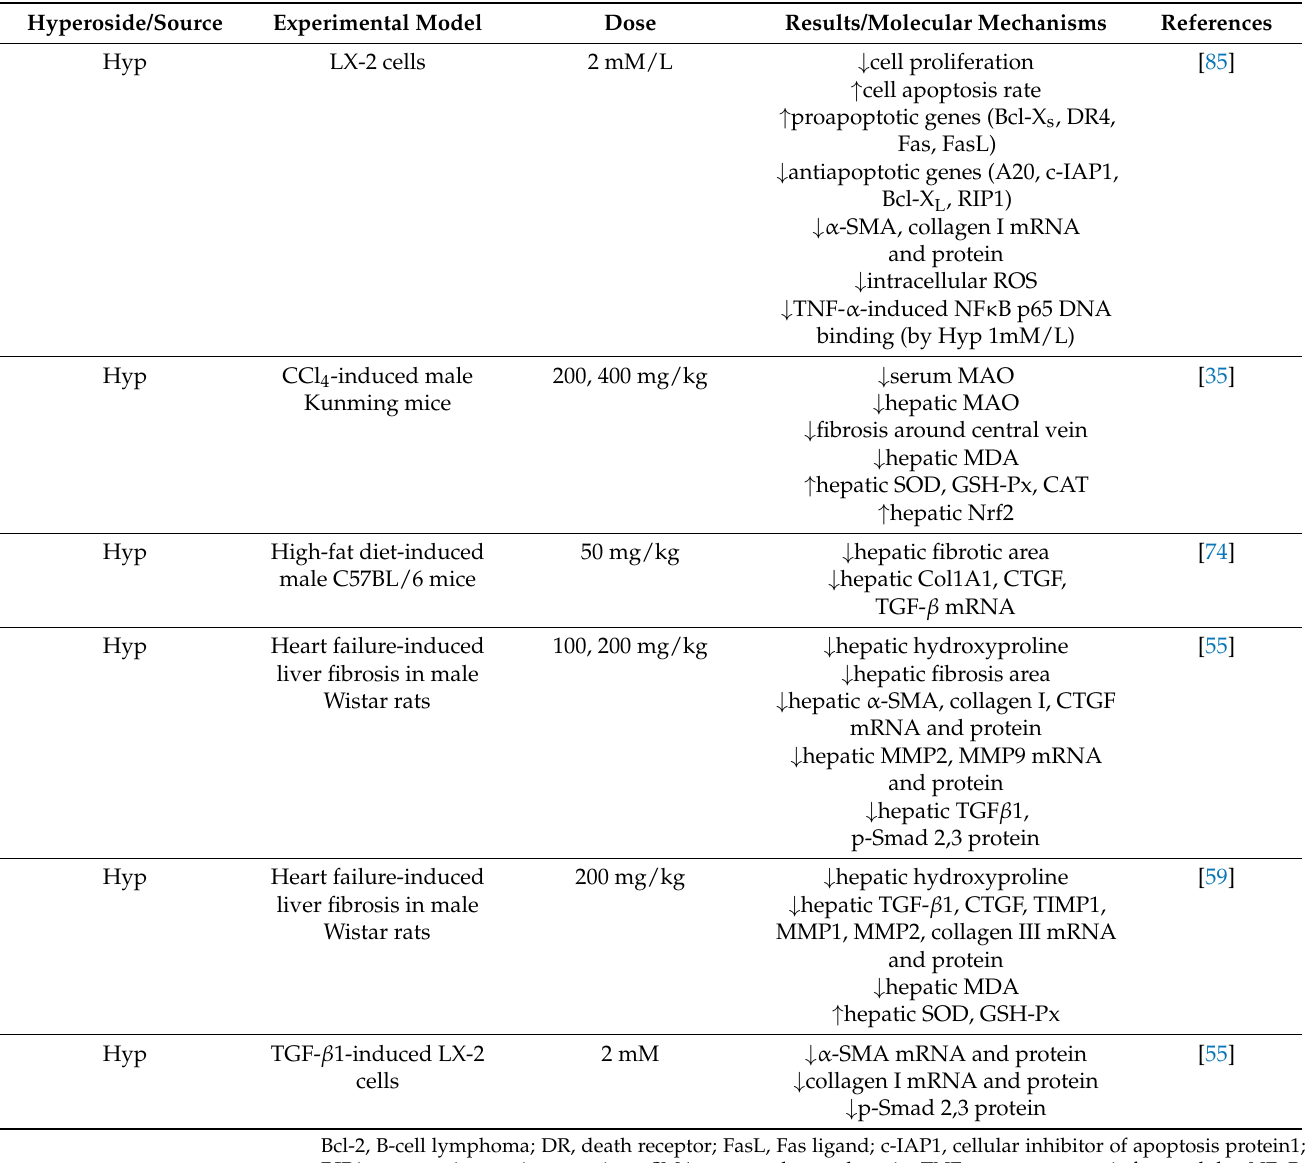
Table 5. Antifibrotic activities of hyperoside (Hyp) in experimental models related to hepatic fibrosis.